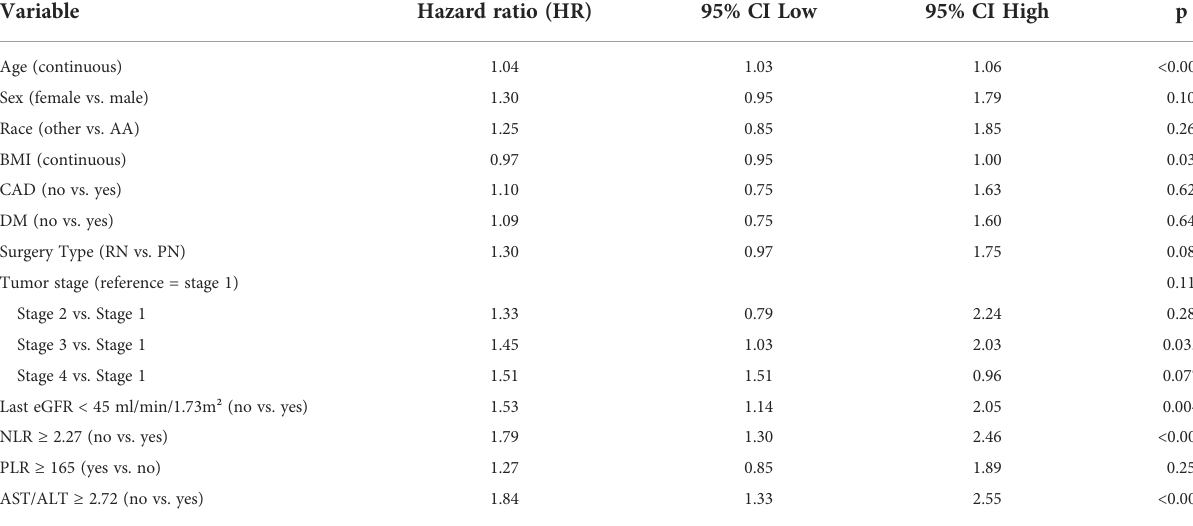
TABLE 2B Multivariable analysis for non-cancer mortality (NCM).